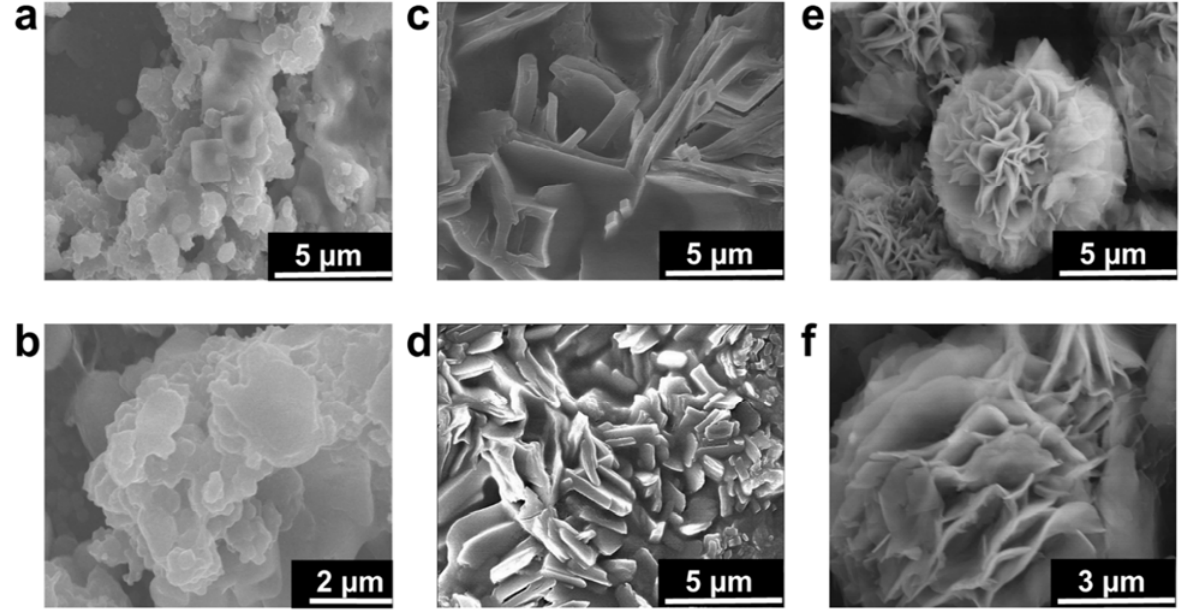
Figure 2. As ‐ synthesized samples of MLSil ‐ 1Ns ‐ x (where “x” is the number of days) ( a – f ). ( a , b ) SEM images of MLSil ‐ 1Ns ‐ 5d synthesized at 150 °C for 5 days. SEM images show that there is no growth of nanosheets. The particles are mostly agglomerated in irregular and spherical order. ( c , d ) SEM images of MLSil ‐ 1Ns ‐ 10d synthesized at 150 °C for 10 days. SEM images show that plate ‐ like particles were formed, the thickness of each sheet was higher in size and intergrowth was not properly attained. ( e , f ), SEM images of MLSil ‐ 1Ns ‐ 15d synthesized at 150 °C for 15 days. SEM images show the MLSil ‐ 1Ns are plates and sheets like morphology in three ‐ dimensional interlocked structure.